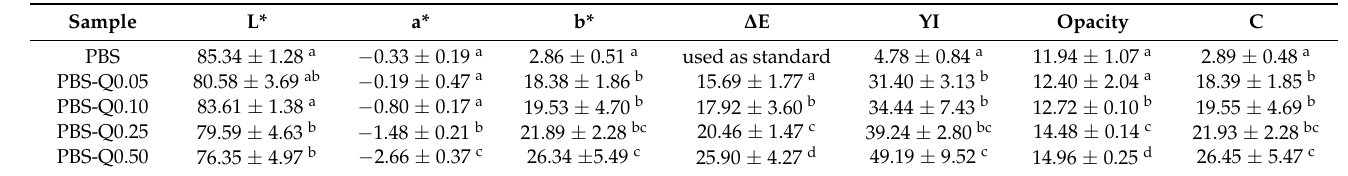
Figure 2. The visual appearance of PBS-based films. Table 2. Color, total color difference ( ∆ E), yellowness index (YI), opacity and chroma (C) of PBS-based